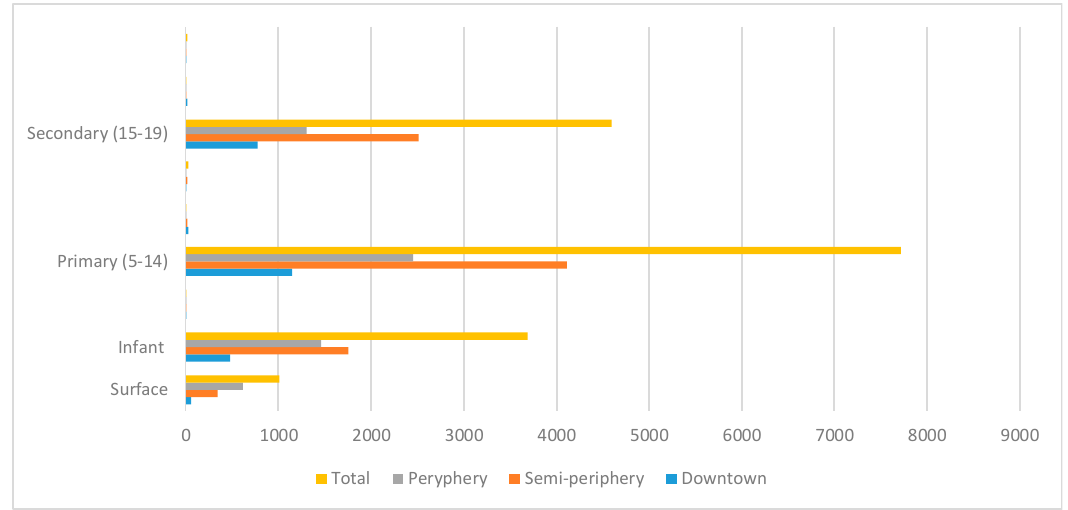
Figure 1. School-age population and schools in urban zones relation. Source: Ciudad Real Council, Education Office of Castilla-La Mancha. Own work.